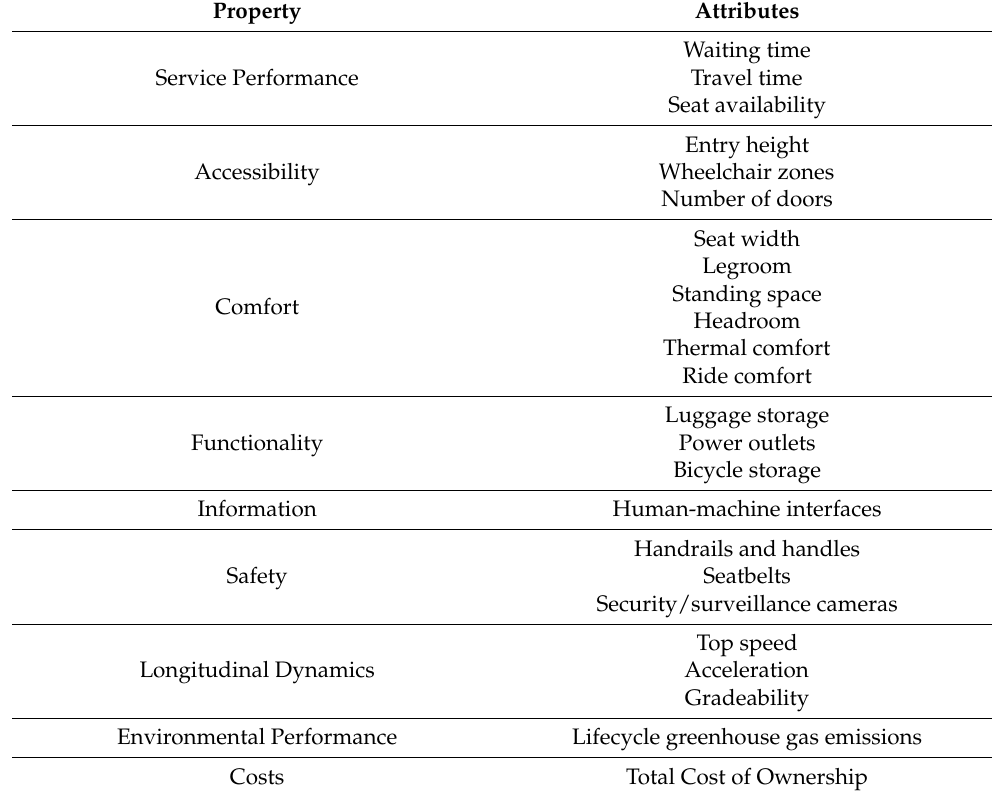
Table 1. Identified properties and attributes of